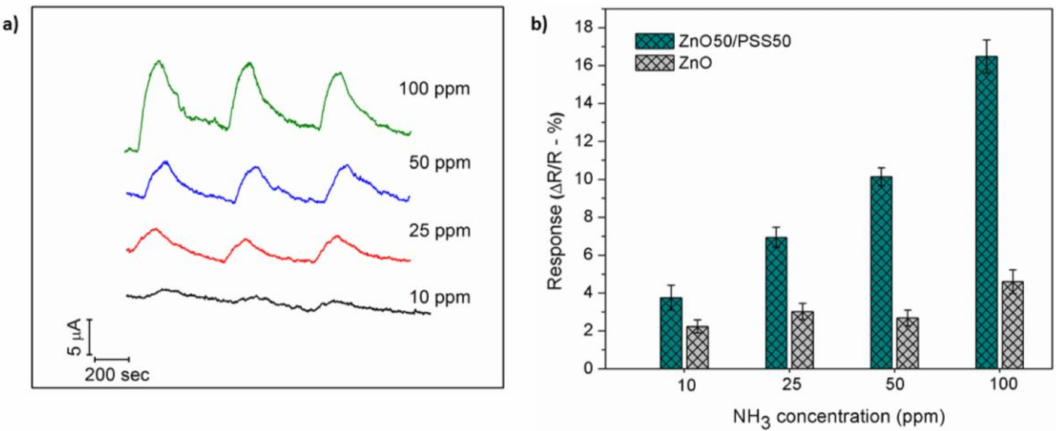
Figure 6. ( a ) Response-recovery profile of ZnO50/PSS50 device as a function of time for NH 3 concentration varying from 10 to 100 ppm, and ( b ) sensing response as a function of NH 3 concentration for ZnO50/PSS50 and PZnO devices,